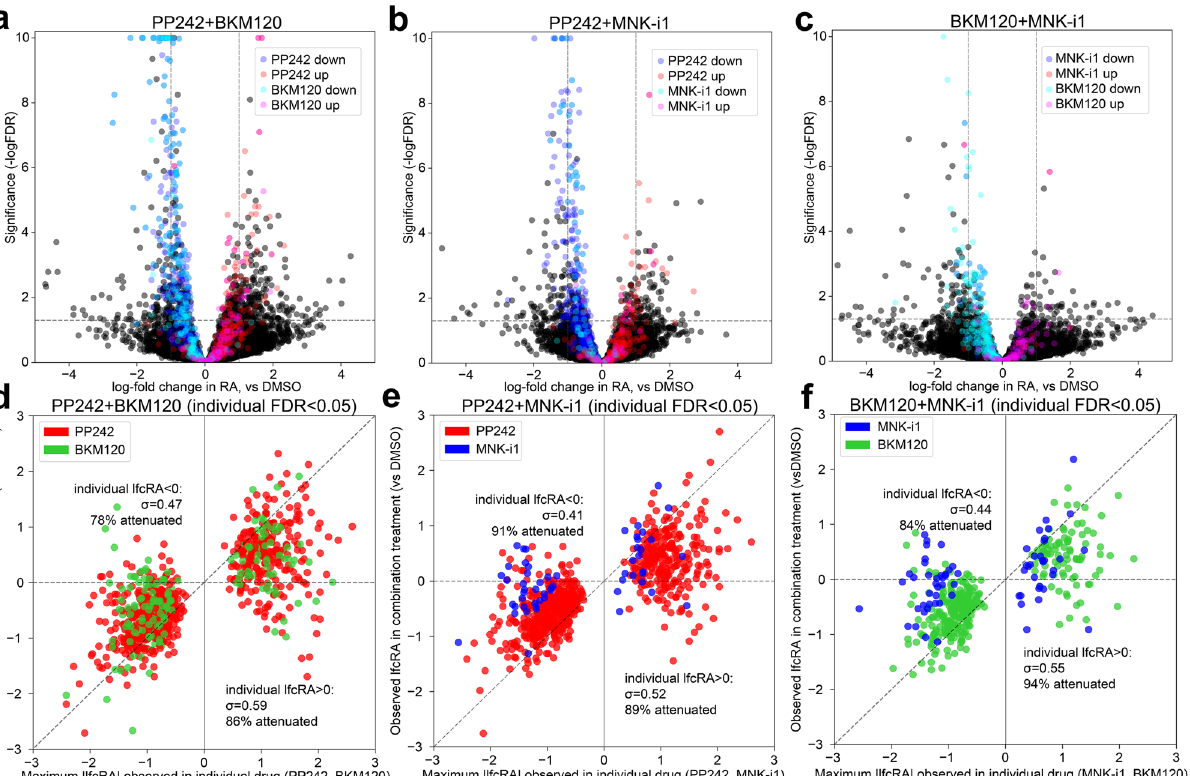
Figure 6. Attenuation of Single-Drug Effects Under Combination Treatments in TS-543 cells. ( a ) – ( c ) Volcano plots of changes in RA observed under drug combinations, color-coded with the upregulated (red, magenta) and downregulated (blue, cyan) significant targets (DESeq2 FDR < 0.05, R v4.0.5) of each combination’s constituent drugs. In each plot, the X axis marks each gene’s observed difference in RA under drug combination treatment relative to DMSO controls, and the Y axis scales inversely with p value (-log 10 (FDR)) to correlate positively with the effect’s significance. Significant targets of both constituent drugs are attenuated in their effects in all combinations, indicated by significance values below the guideline y = − log 10 (0.05) and effect sizes reduced towards x = 0, relative to their distributions in the volcano plots in Fig. 5 (by definition y > − log 10 (0.05)). ( d ) – ( f ) Scatterplots comparing the maximum observed effect in either individual drug on the X axis with its observed effect under combination treatment on the Y axis, for the set of genes significantly impacted by each drug combination’s two constituent drug treatments. Guidelines at Y = 0 and X = Y aid visualization of the attenuation in gene-specific effects of the individual drugs in combination. Most genes fall between Y = 0 and X = Y, indicating a lesser change in RA in the same direction under combination treatment compared with its maximum effect observed in singular